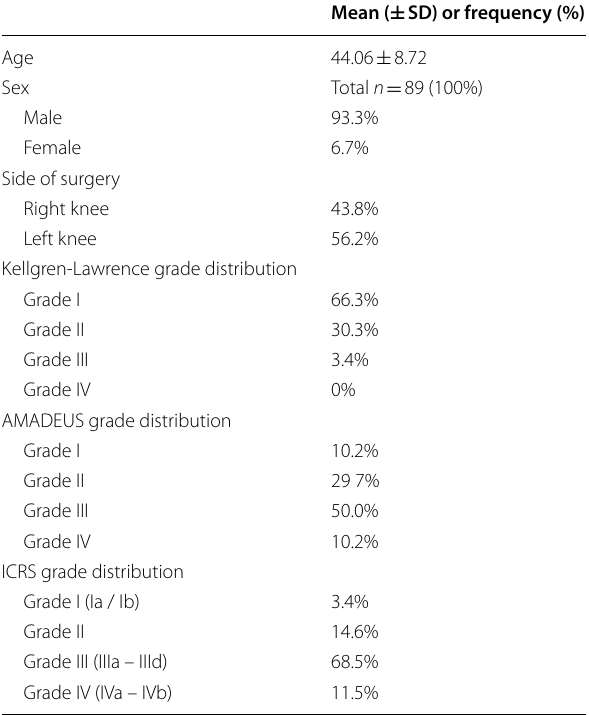
Table 1 Descriptive statistics of the study cohort